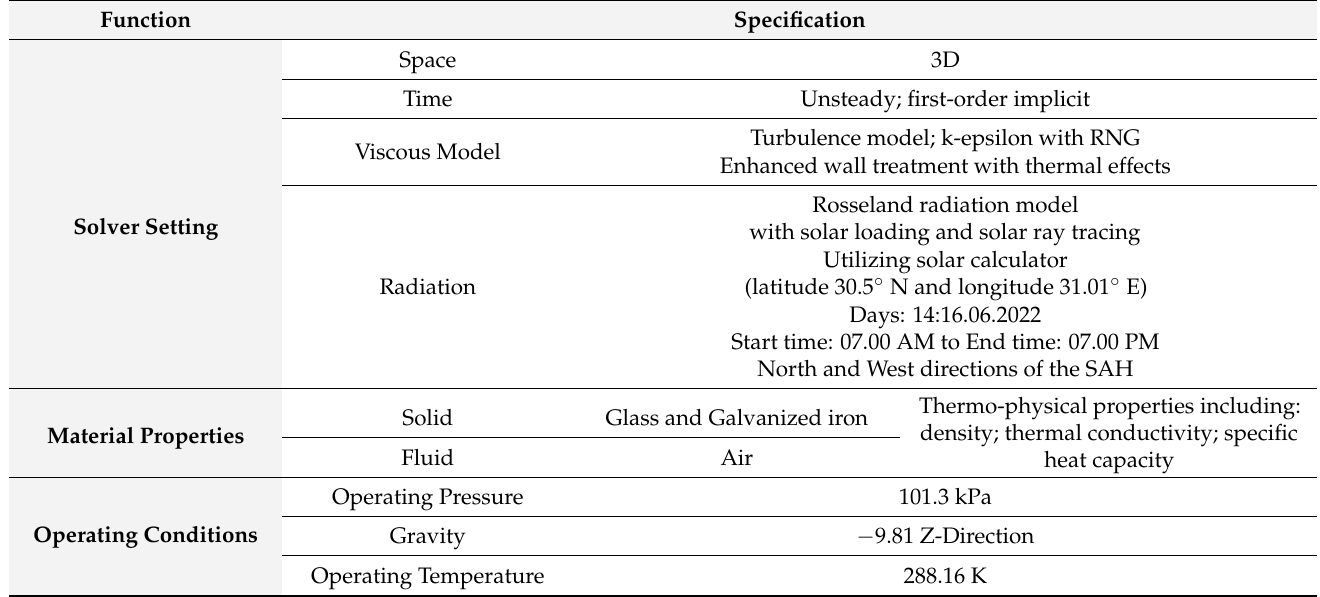
Table 2. Input parameters and models of the